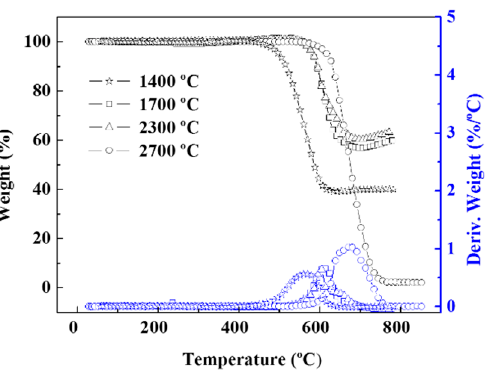
Figure 4. Thermogravimetric analysis graph of annealed soot.